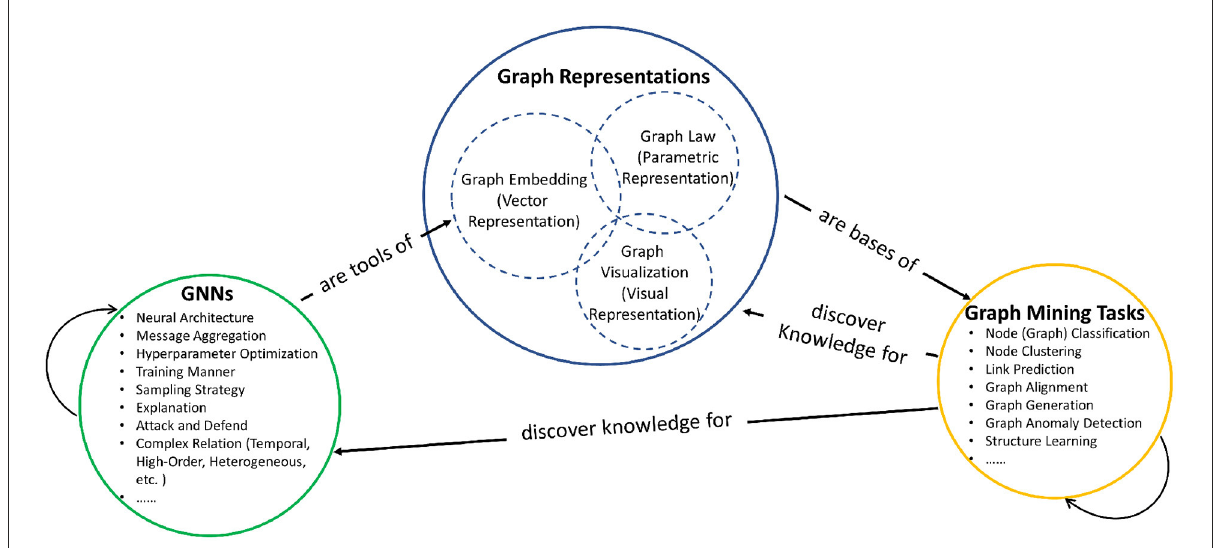
FIGURE1 Relationships among graph mining, graph representations, and graph neural networks.